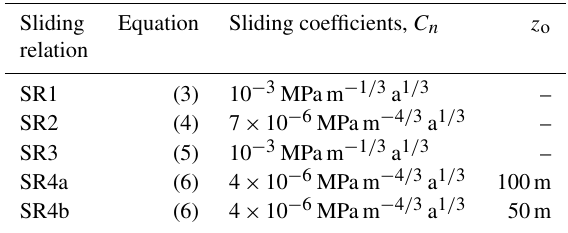
Table 1. Sliding relations and constants used in the current study.